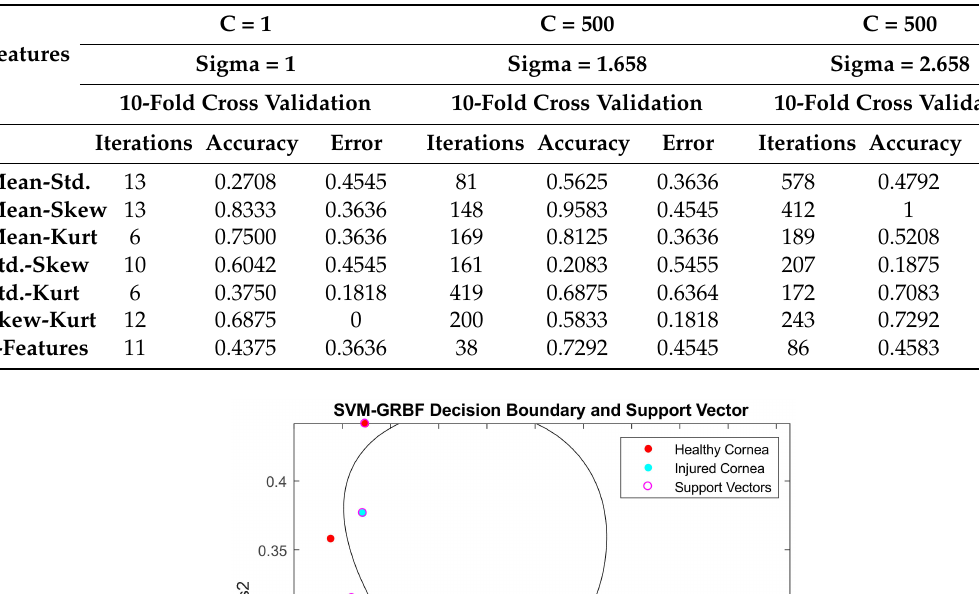
Table 4. Four features classification using SVM-GRBF.